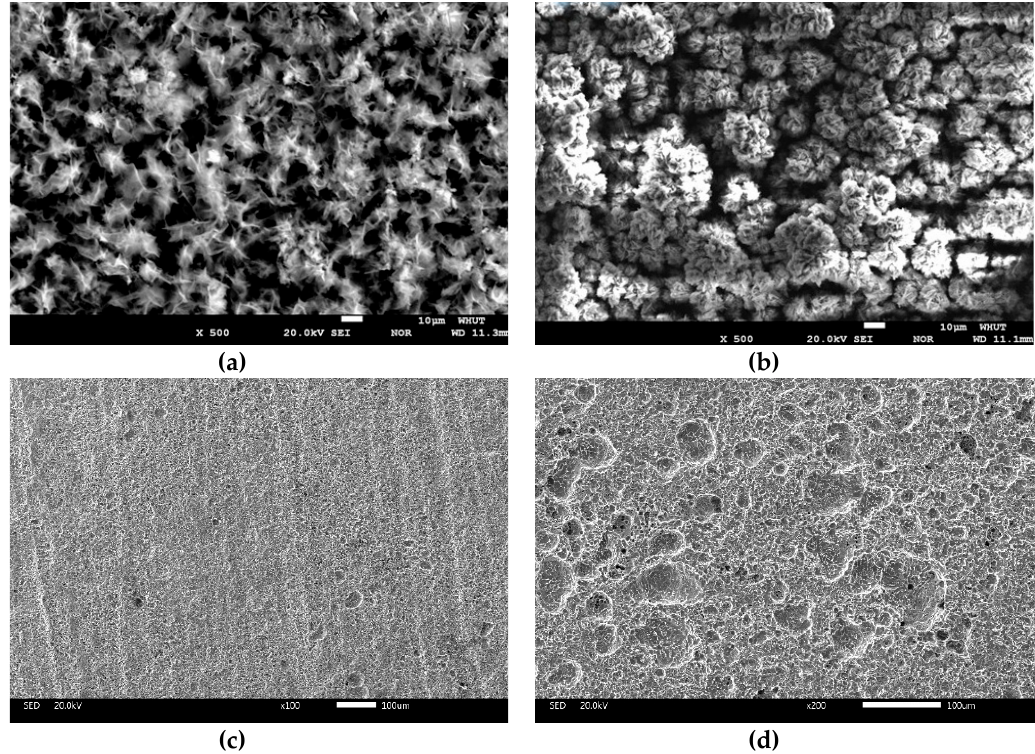
Figure 1. SEM macro-morphologies characteristics of Q235B steel in desulfurization solution with 7 days ( a ) and 35 days ( b ); The corresponding SEM macro-morphologies characteristics after the corrosion products were removed by acid pickling for 7 days ( c ) and 35 days ( d ).